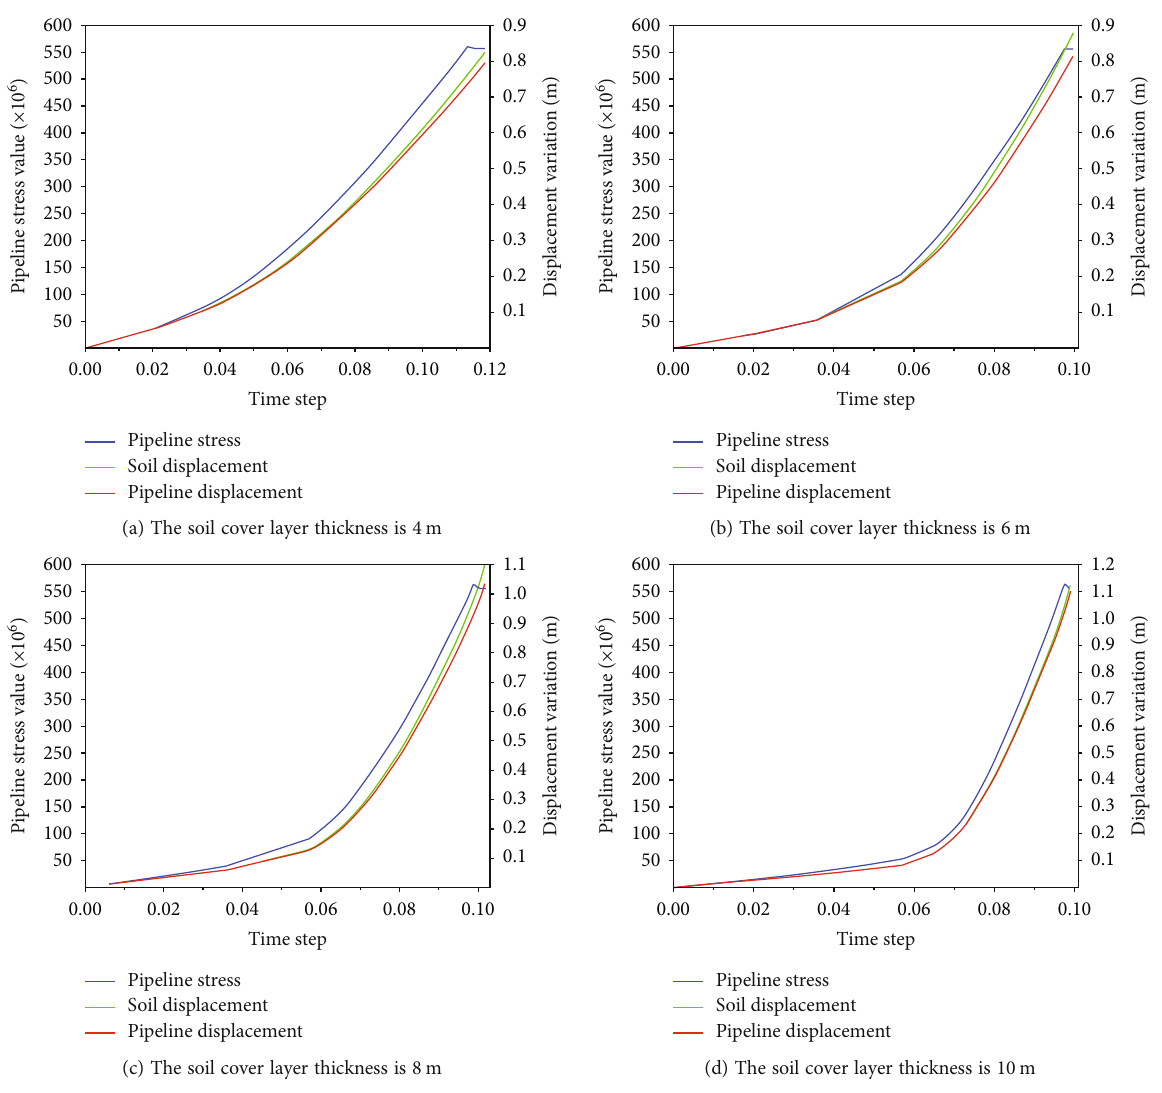
Figure 12: The diagrams of pipeline stress, displacement, and soil displacement under di ff erent cover layer